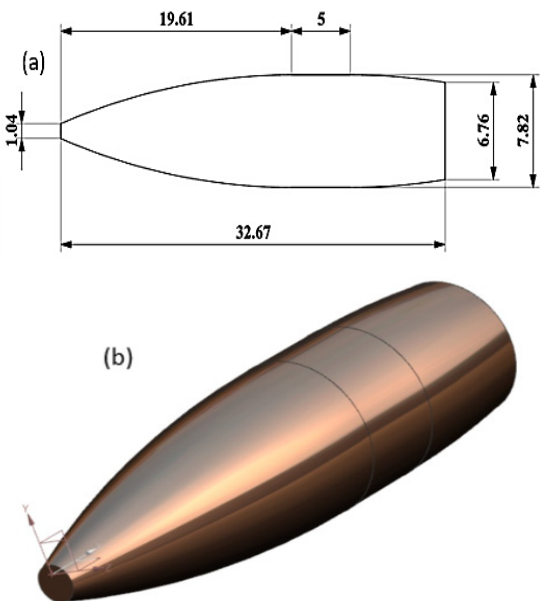
Figure 2: a) Geometrical details of 7.82 mm ammo. All dim– ensions are in millimeters, b) 3-Dimensional isometric view of the bullet. The specifications are taken from Reddy et al.